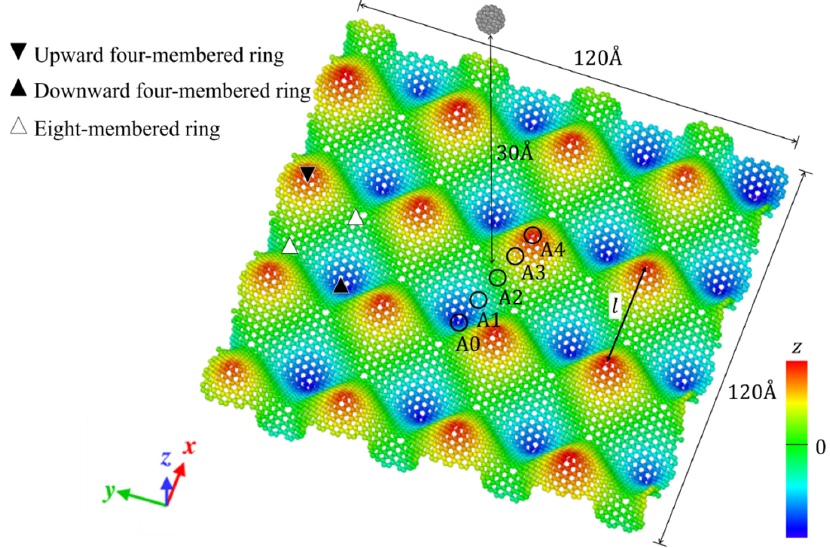
Figure 2. Illustration of the simulation model with detailed depiction of the wavy GS.